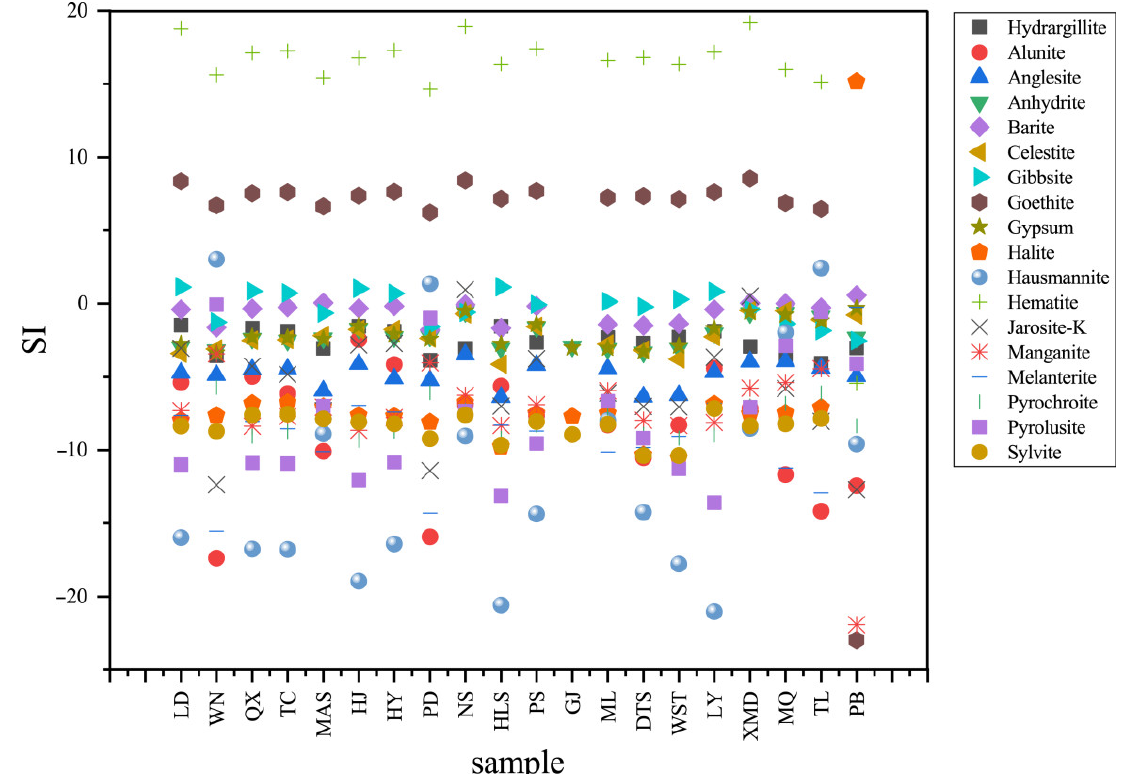
Figure 12. Saturation indices values of groundwater samples, with respect to